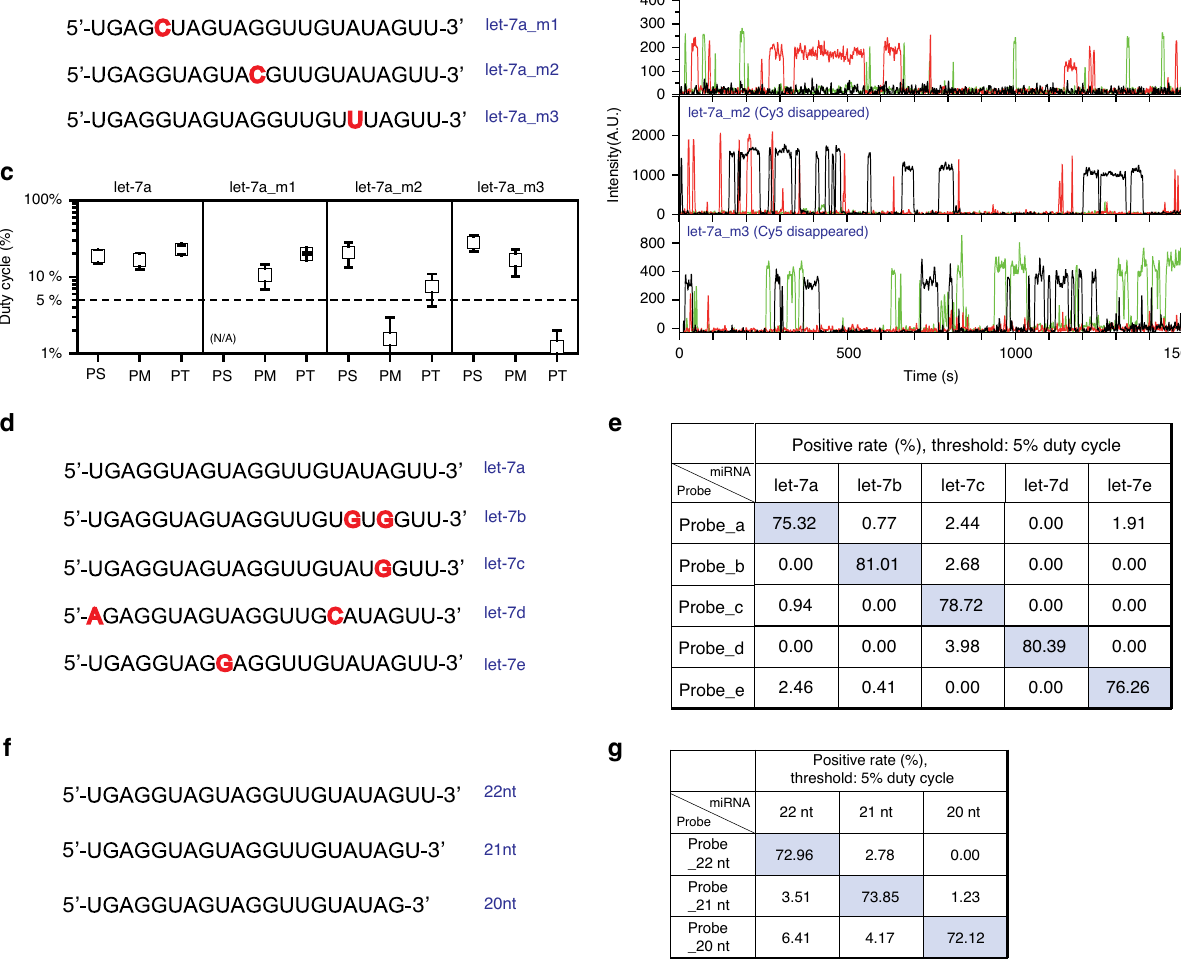
distinguish mono- and bi-uridylated miRNAs with high speci fi - city. In Fig. 2e, g, we arbitrarily chose 5% as the duty cycle threshold. When a better speci fi city was required, however, the higher threshold value could be used by sacri fi cing the detection ef fi ciency (de fi ned as the ratio of the true positive to the sum of the true positive and the false negative; Supplementary Figs. 3 – 5).